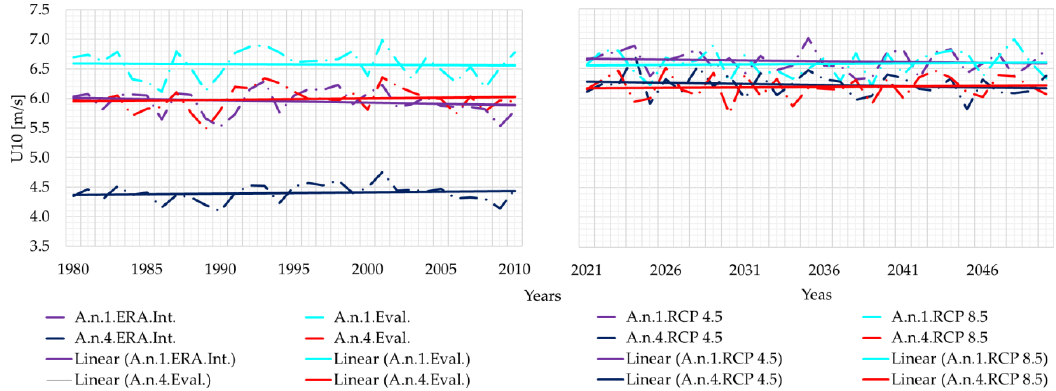
Figure 3. Annual averages of the wind speed at 10 m height for two of the most representative points located in the Romanian nearshore of. ERA.Int and Eval data, time interval 1981–2010, RCP4.5 and RCP8.5 data, time interval 2021–2050.